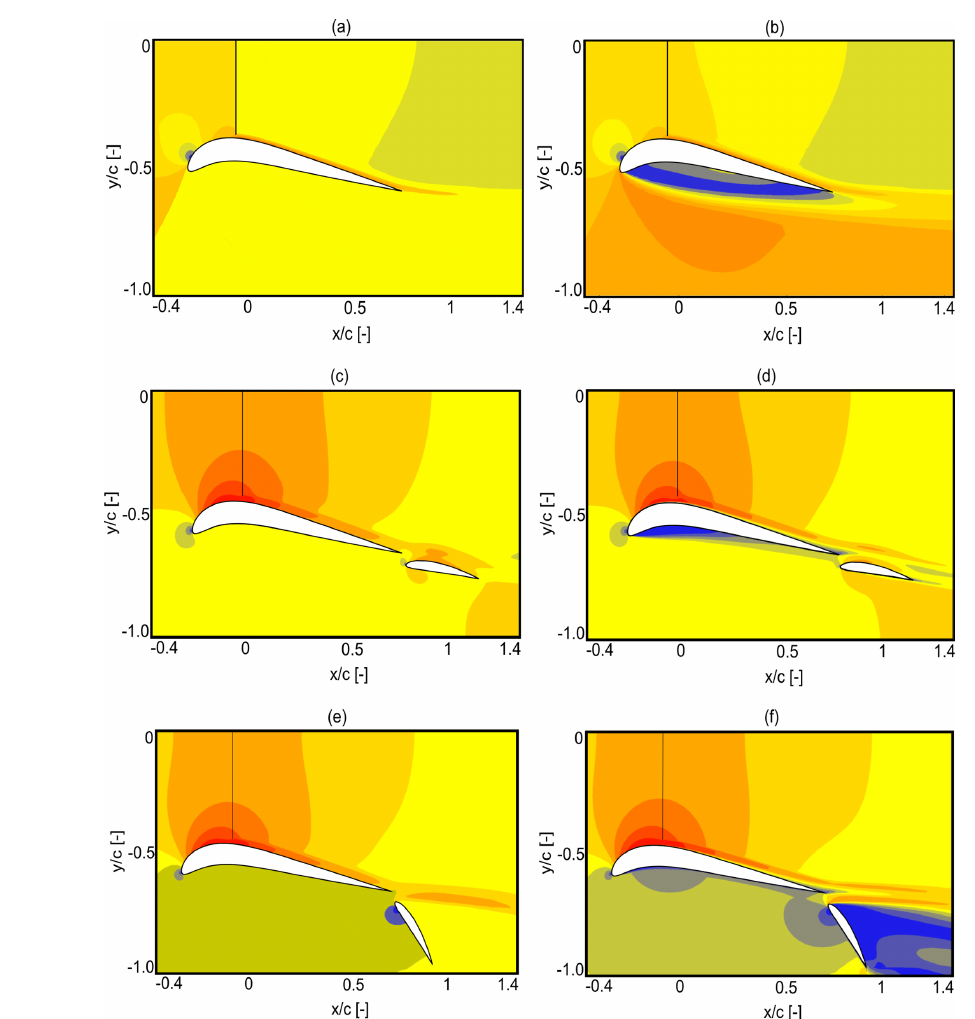
Figure 10. Velocity contours colored with normalized free-stream velocity obtained using the (a) panel method with no flap, (b) RANS method with no flap, (c) panel method with ζ = 5% and θ = 10 ◦ , (d) RANS method with ζ = 5% and θ = 10 ◦ , (e) panel method with ζ = 5% and θ = 70 ◦ , and (f) RANS method with ζ = 5% and θ = 70 ◦